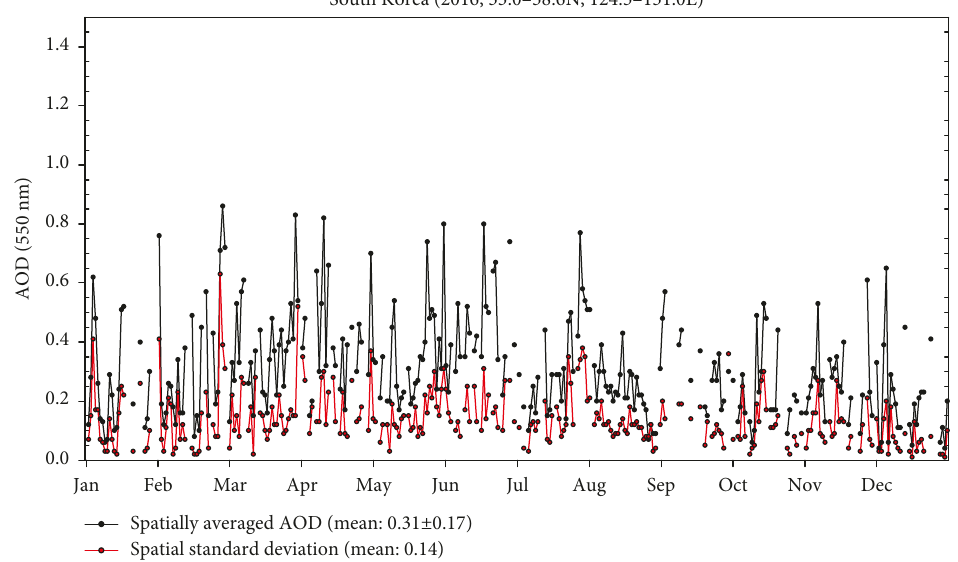
Figure 11: Time series of daily averaged and spatial standard deviation of AOD